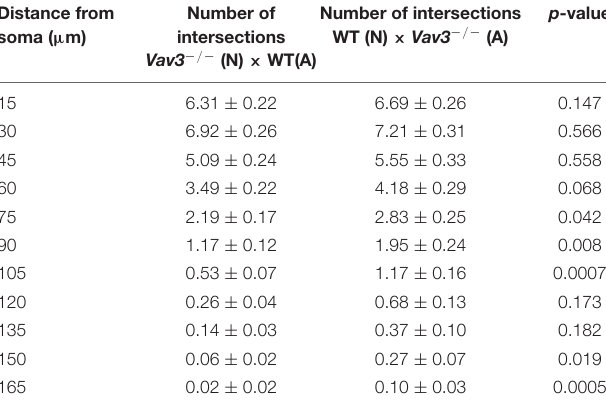
TABLE 4 | Intersection numbers of wildtype neurons cultured with Vav3 − / − astrocytes in comparison to Vav3 − / − neurons cultured with wildtype astrocytes after cultivation time of 12